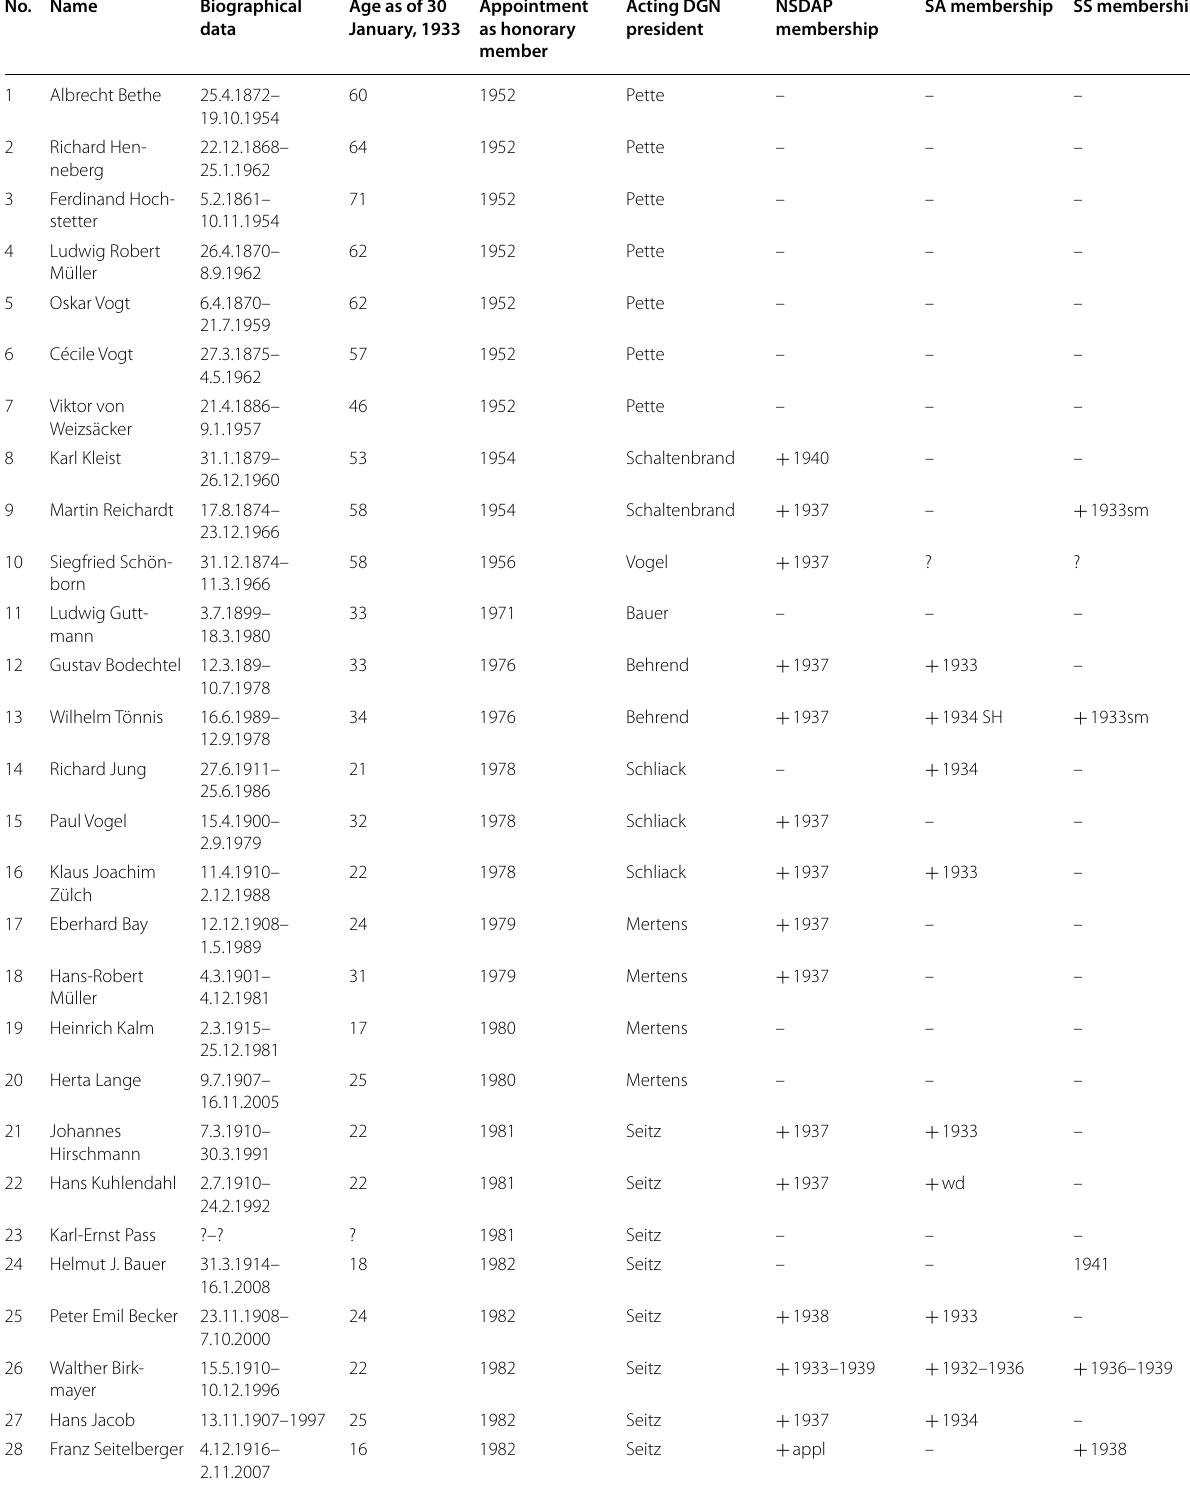
Table 1 Honorary members of the German Neurological Society (DGN) (1952–1982) and their membership in NSDAP, SA, and